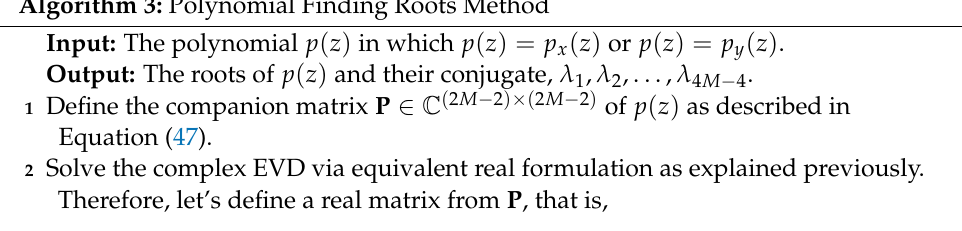
Algorithm 3: Polynomial Finding Roots